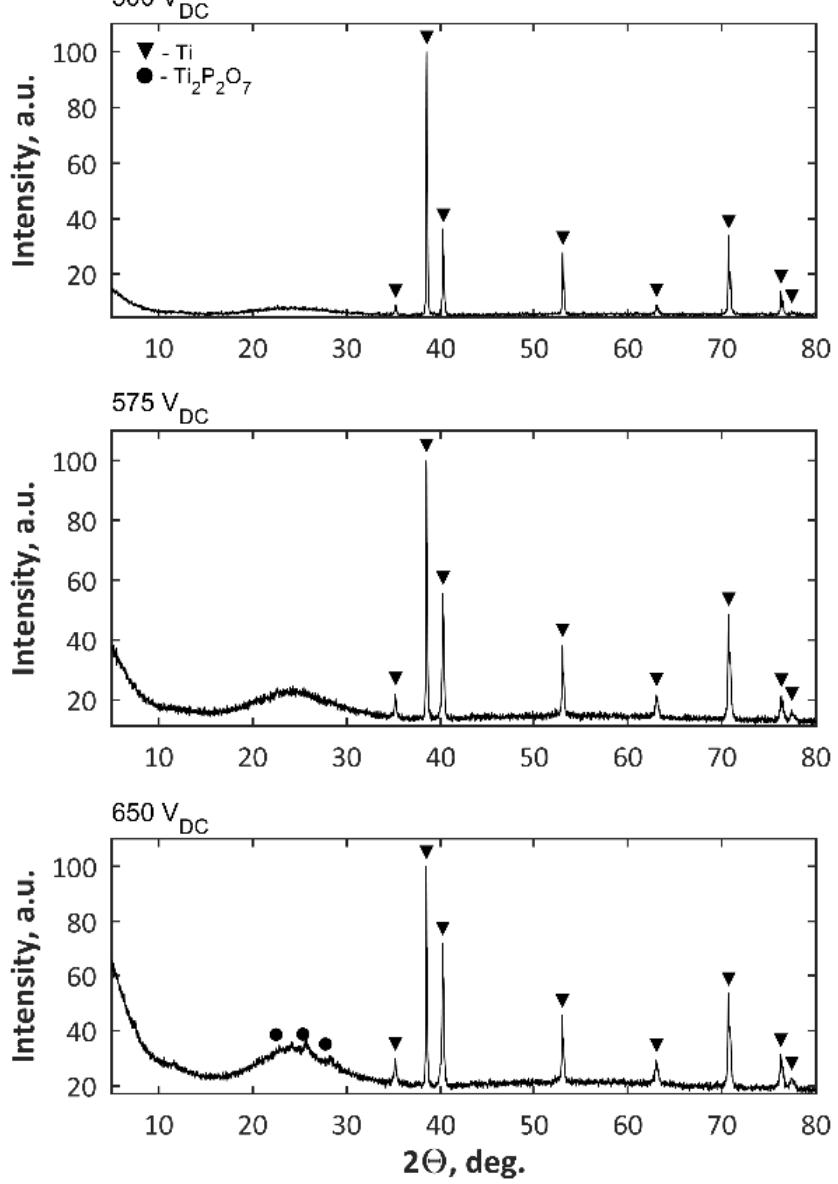
Figure 6. XRD (X-ray Diffraction) patterns of coatings formed on CP Titanium Grade 2 after PEO process at voltages 500 V DC , 575 V DC , 650 V DC , in 1 L of 85% H 3 PO 4 with the additions of 125 g Ca(NO 3 ) 2 · 4H 2 O, 125 g Mg(NO 3 ) 2 · 6H 2 O, 125 g Zn(NO 3 ) 2 · 6H 2 O, and 125 g Cu(NO 3 ) 2 · 3H 2